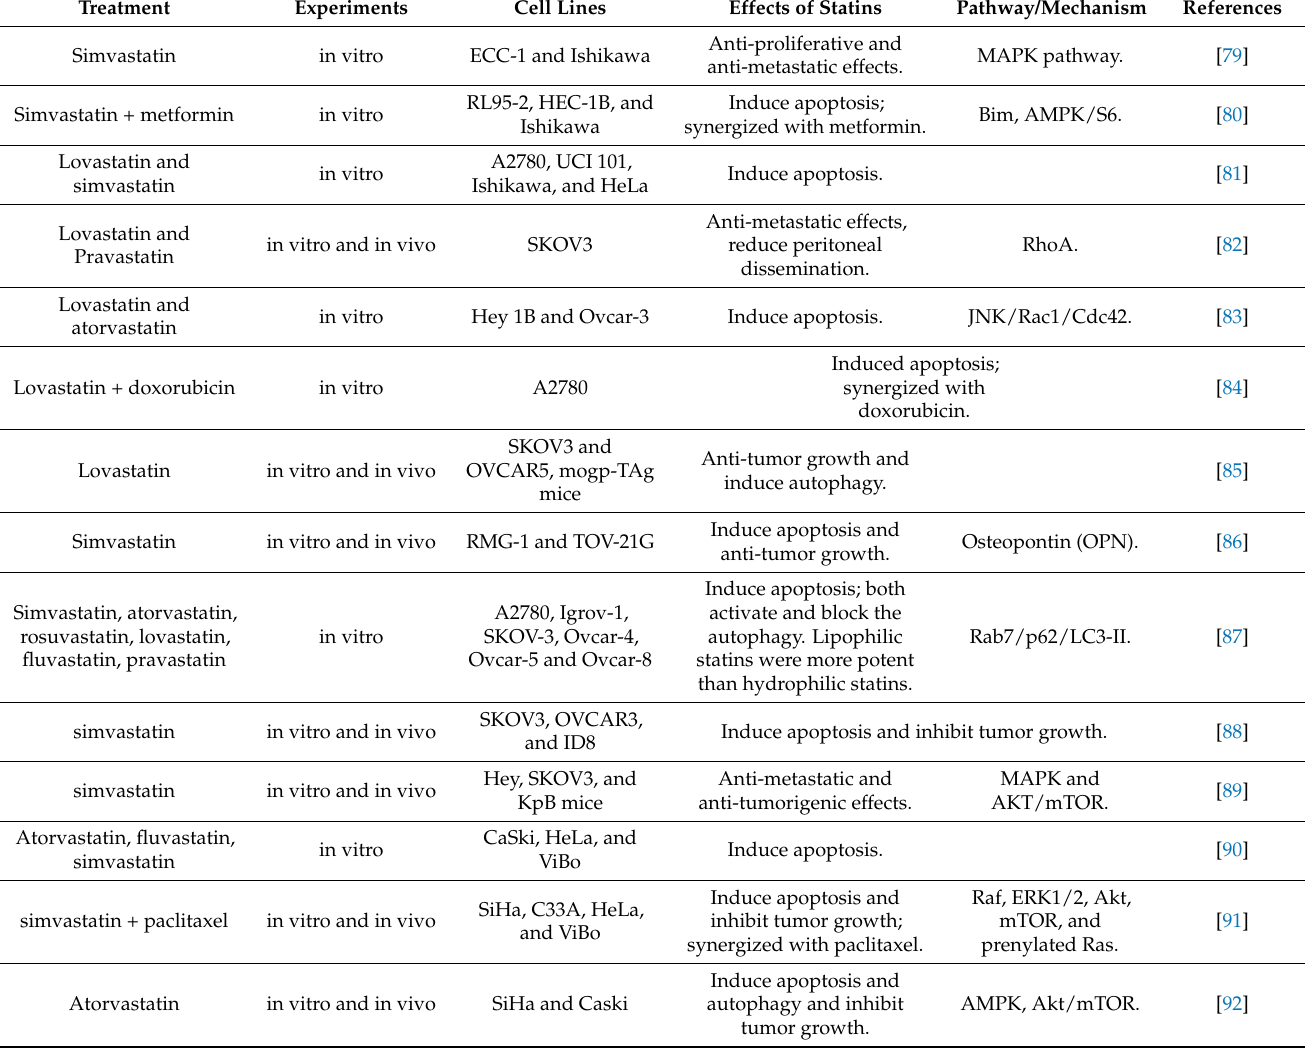
Table 5. The preclinical studies of statin in gynecological